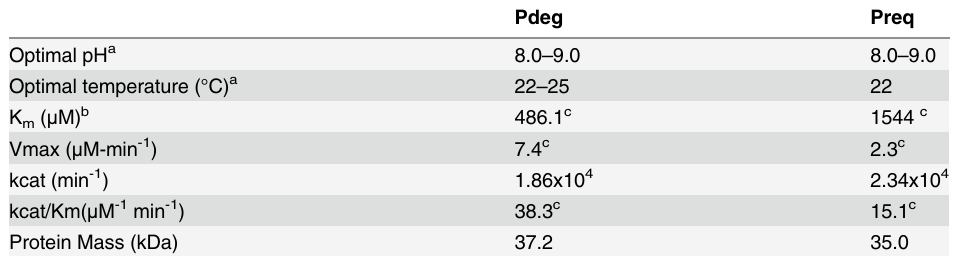
Table 3. Enzymatic properties of recombinant Bc3750-His 6 (Pdeg) and Bc3749-His 6